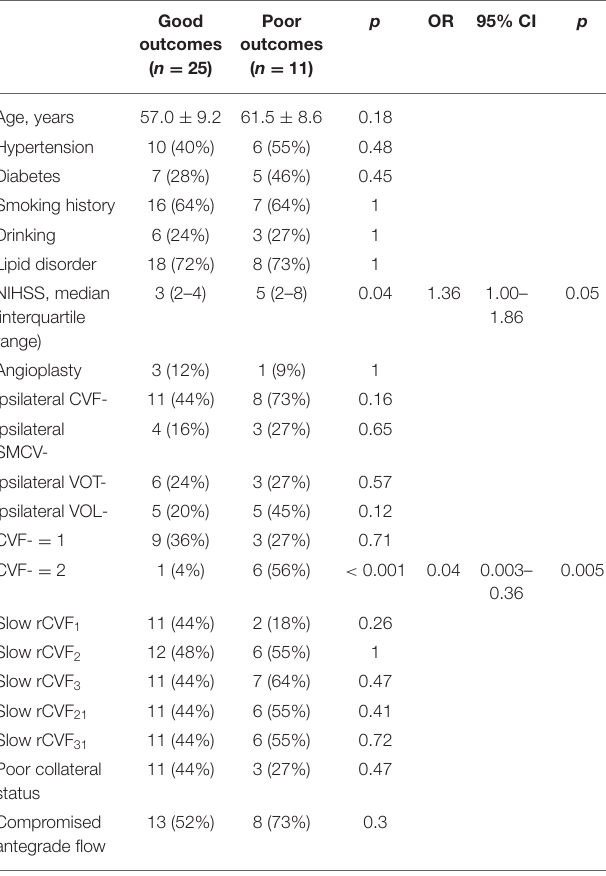
TABLE 5 | Univariate associations of baseline characteristics and clinical outcomes at 3